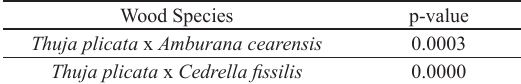
Table 8. Relation between insoluble lignin content.